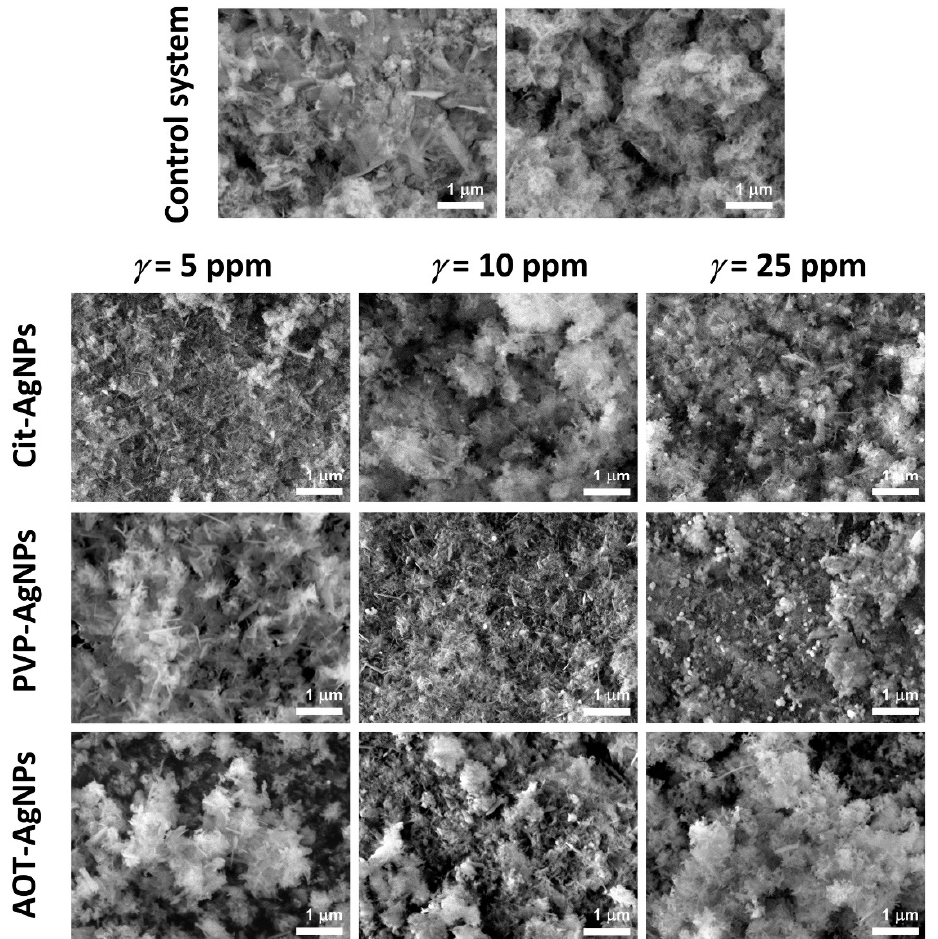
Figure 8. SEM micrographs of precipitates obtained after 60 min reaction time in the control system and in the presence of different concentrations of silver nanoparticles (AgNPs) stabilized with citrate (cit-AgNPs), poly(vinylpyrrolidone) (PVP-AgNPs), and sodium bis(2-ethylhexyl) sulfosuccinate (AOT-AgNPs). c (CaCl 2 ) = c (Na 2 HPO 4 ) = 4 · 10 ‒ 3 mol dm ‒ 3 , pH 7.4, 25 °C.